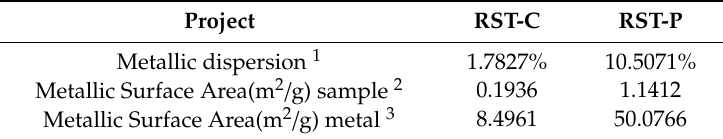
Table 4. Metallic dispersion by CO pulse